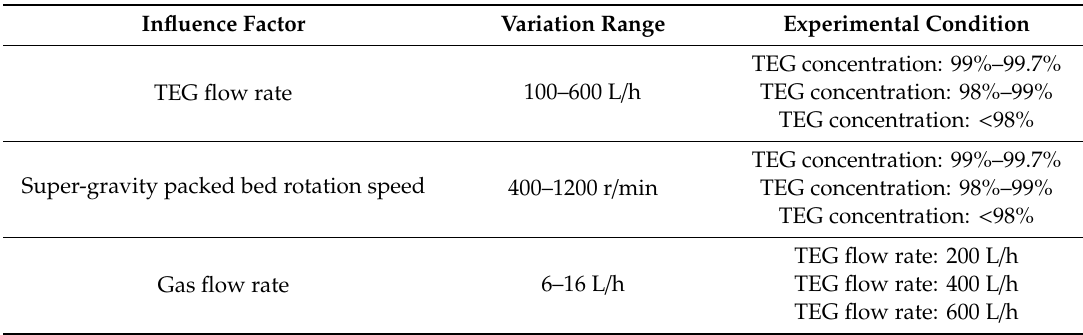
Table 3. Experimental